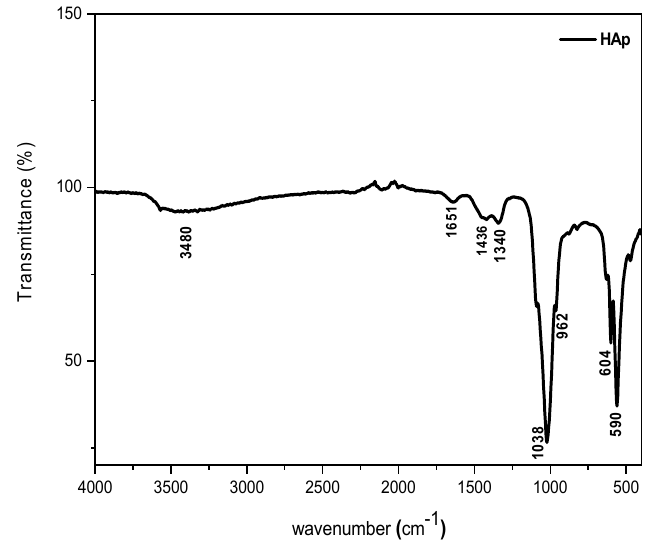
Figure 1. Typical FT-IR spectrum of the synthesized HAp.